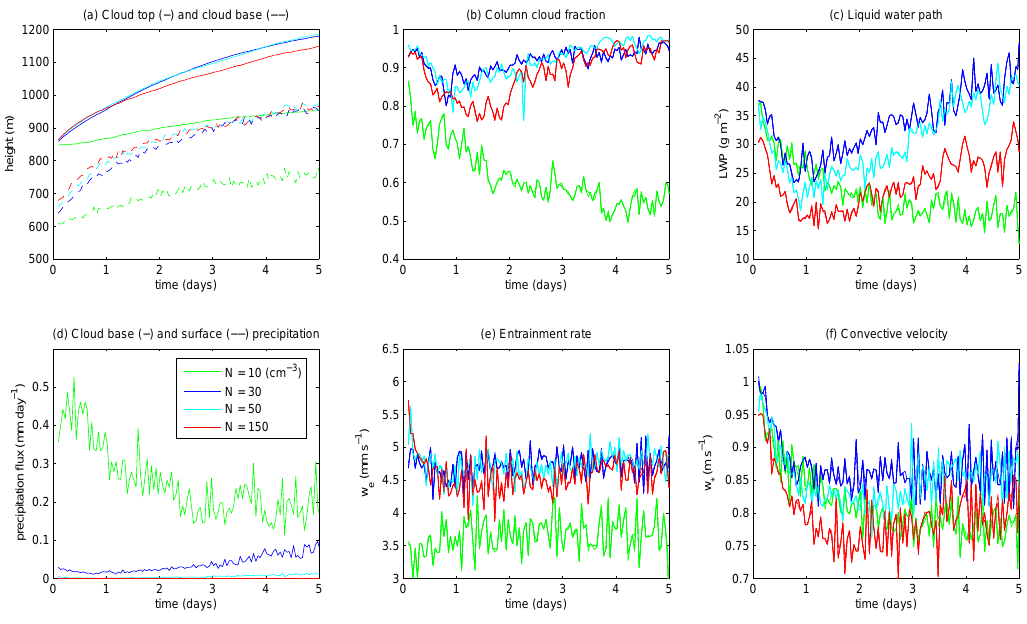
Fig. 1. LES time series for N =10, 30, 50 and 150 cm − 3 : (a) highest cloud top and lowest cloud base, (b) column cloud fraction, (c) LWP, (d) Cloud base precipitation averaged across all grid columns – surface precipitation is negligible in all cases, (e) entrainment rate, (f) convective velocity.